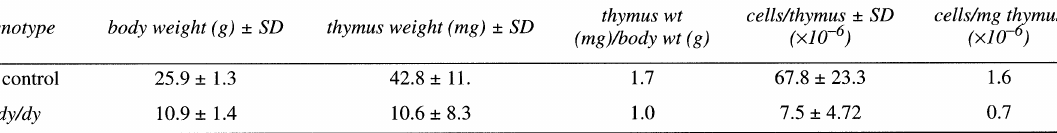
TABLE Analysis of dystrophic mouse mass and cell numbers a’b thymus wt cells